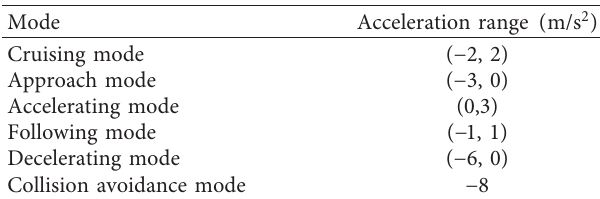
Table 10: Values of the acceleration range in six modes.